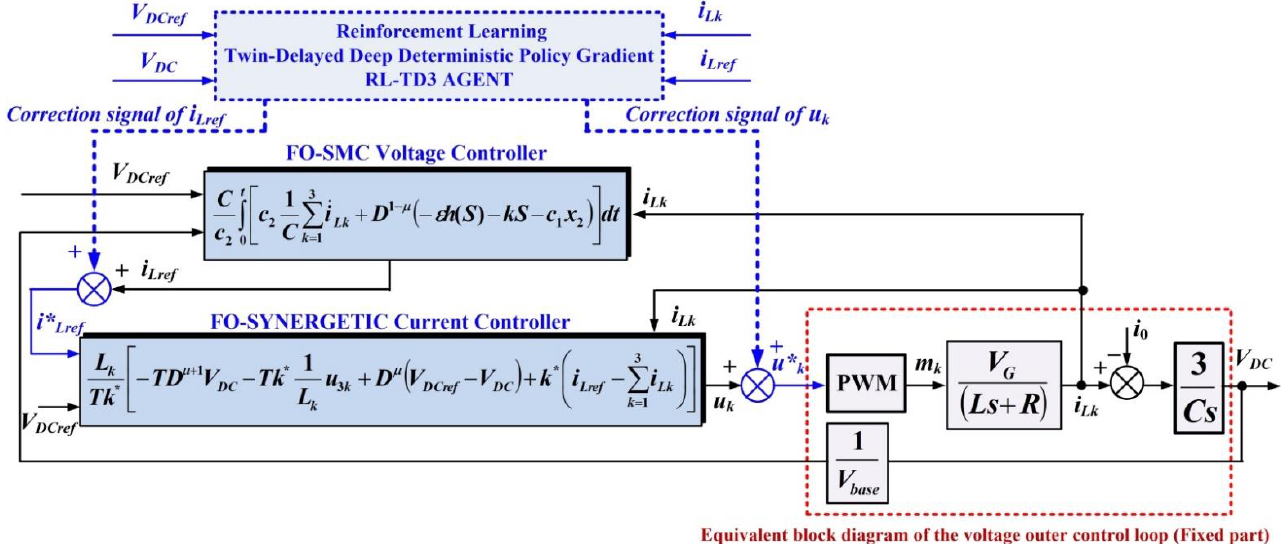
Figure 13. Block diagram modeled using the transfer function for the control system of the power electronic converter using an FO SMC controller for the voltage outer control loop and an FO synergetic controller for the current inner control loop combined with the RL-TD3 agent.